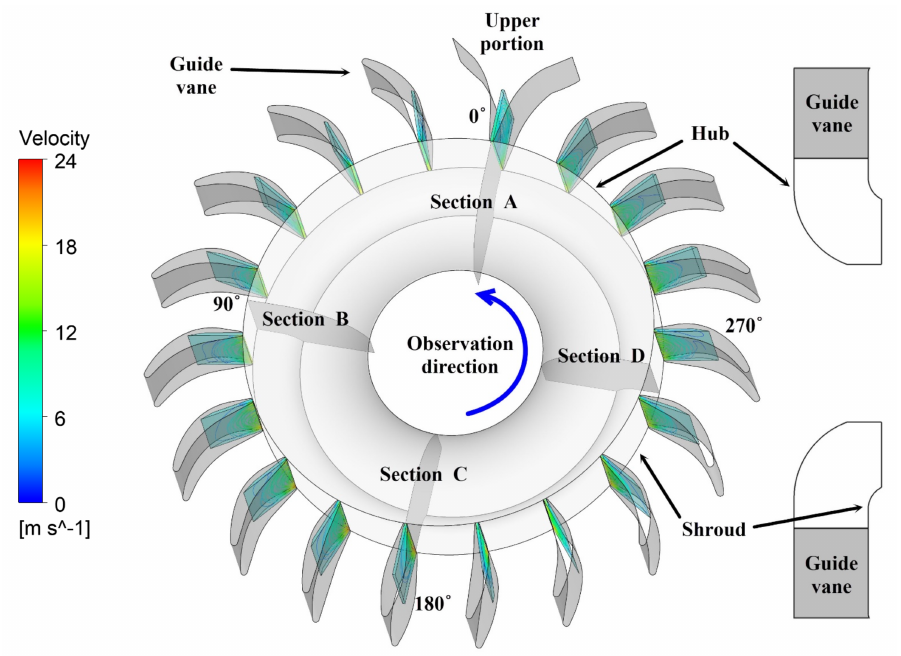
Figure 6. The sections and streamline in the self-induced